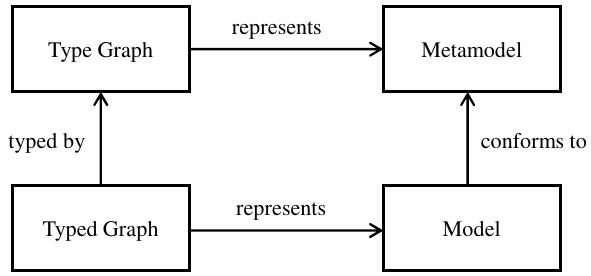
Figure 4. Relationship between models and their graphical representation.